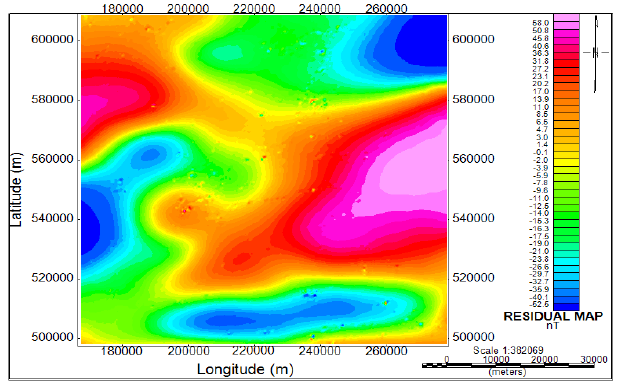
Figure 3: Residual magnetic map of the study area.